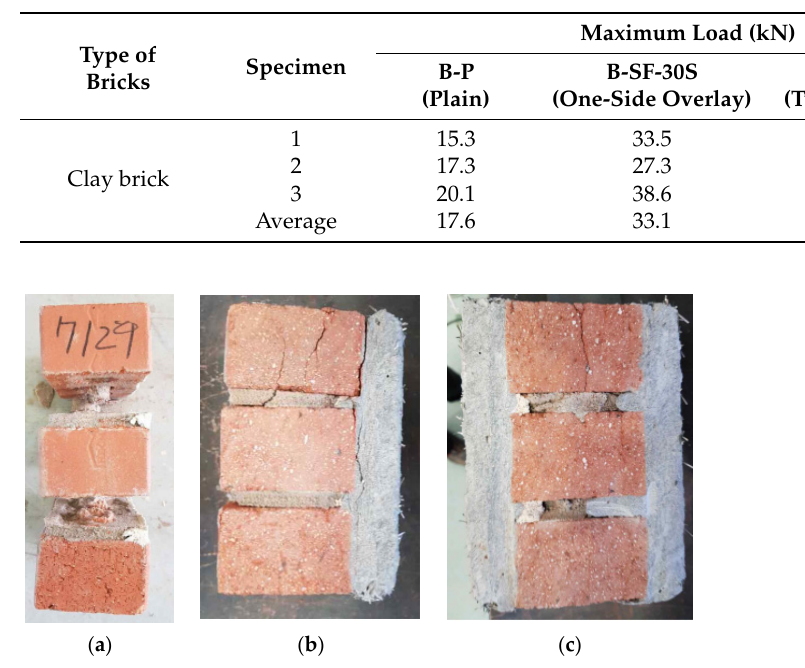
( a ) ( b ) Figure 11. Transfer of test load through mortar joints and interface between masonry layer and AS- FRM overlay: ( a ) Strengthening on one side; ( b ) strengthening on both sides. The bond strengths of the overlay-to-masonry interface calculated using Equations (1)–(3) are summarized in Table 7. The bond strengths for strengthening on one side and both sides were 0.716 and 0.884 MPa, respectively. The lower bond strength by strength- ening on one side is attributable to the normal stress exerted on the interface due to the eccentricity between the interface and the line of action for loading. In addition, bond